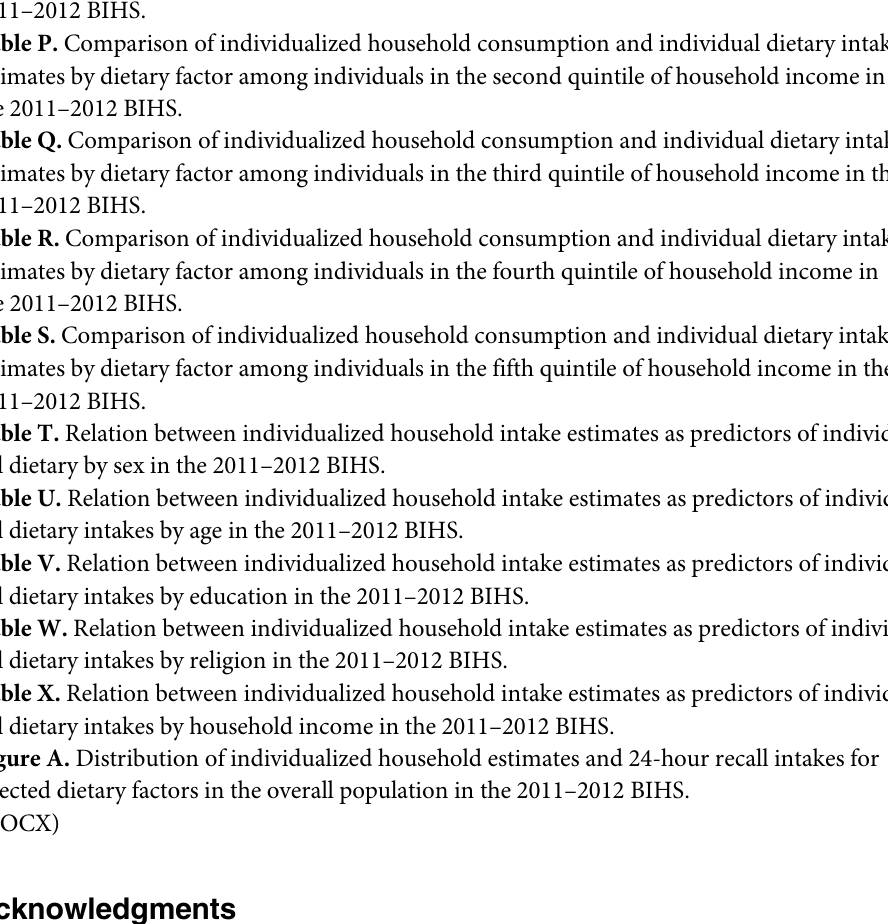
Table O. Comparison of individualized household consumption and individual dietary intake